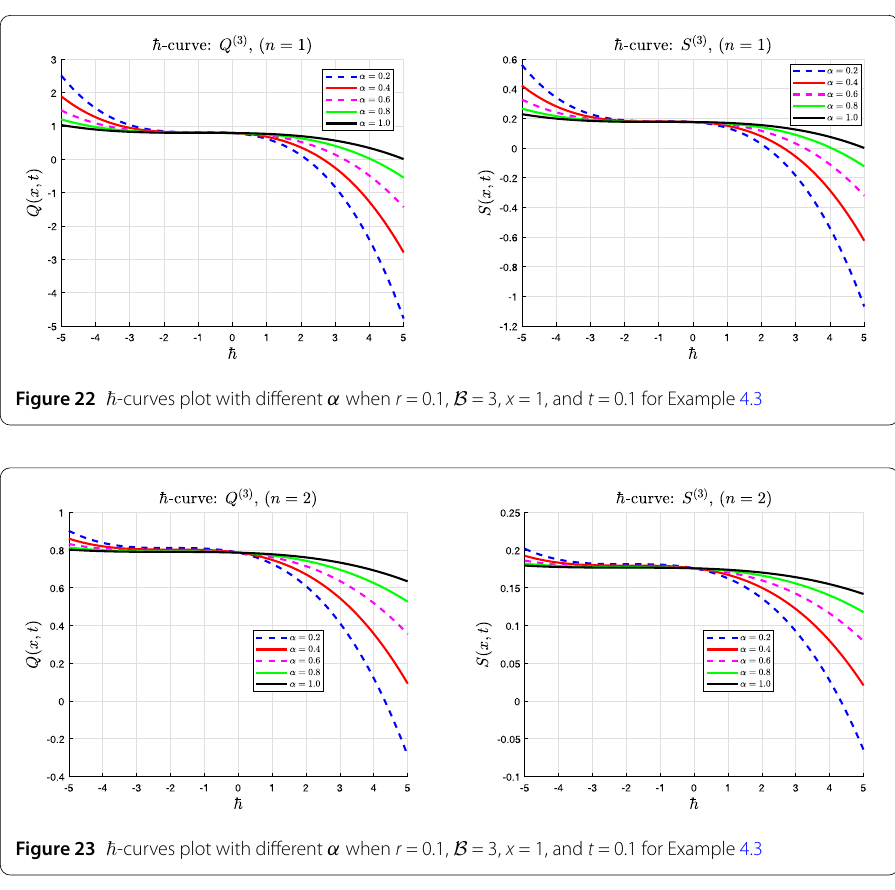
our optimal choice of the values of (cid:2) in our analysis. Horizontal line test is used to obtain intervals containing optimal